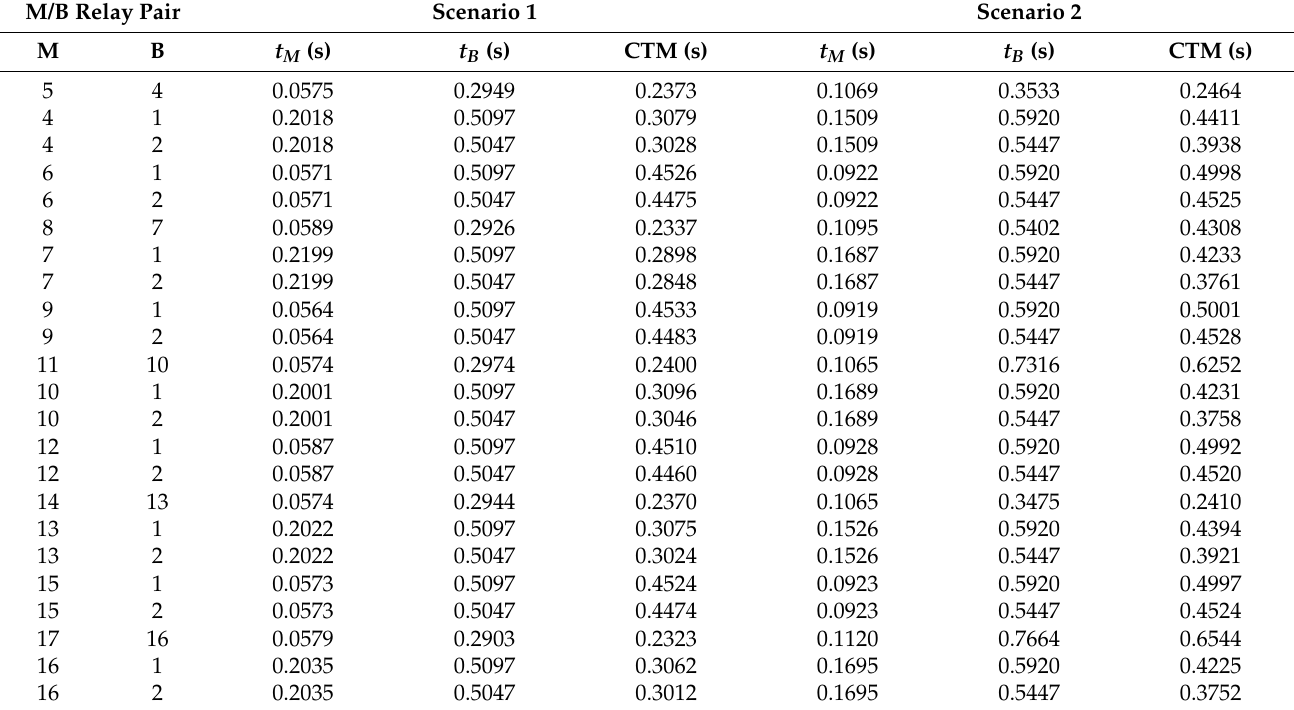
Table 16. Coordination check of Test Model 2.